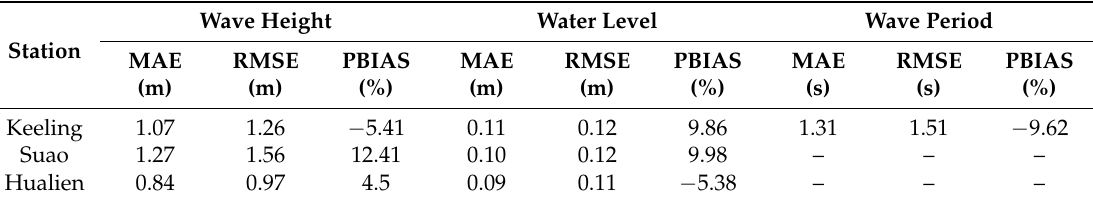
Table 2. Statistical errors at available tidal gauge stations and wave buoys for model validation.